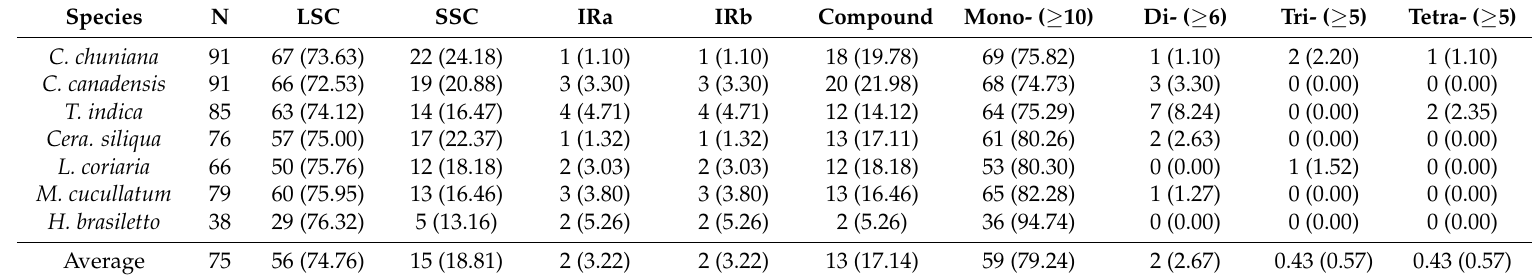
Table 3. Number of chloroplast SSRs in different regions or different types present in the seven species from caesalpinioid legumes.